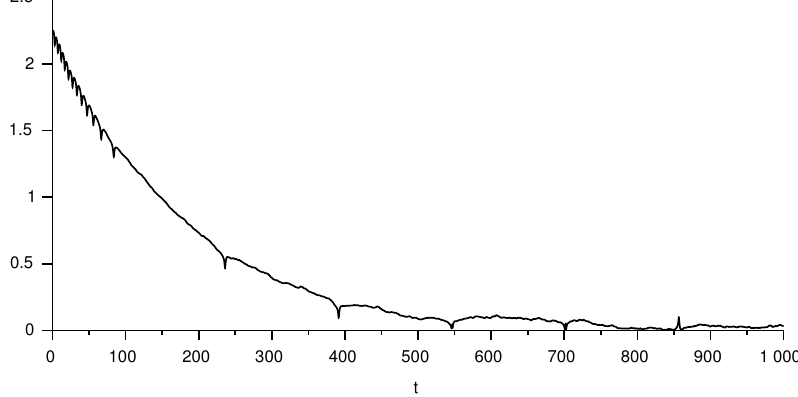
Figure 7. Norm of the synchronization error in the adaptation